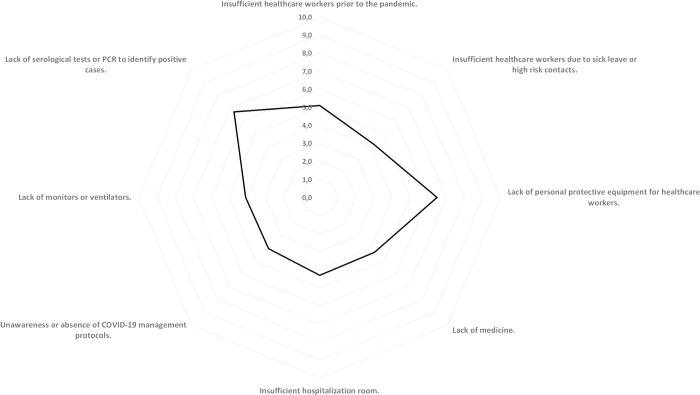
Main obstacles when caring for patients with COVID-19.